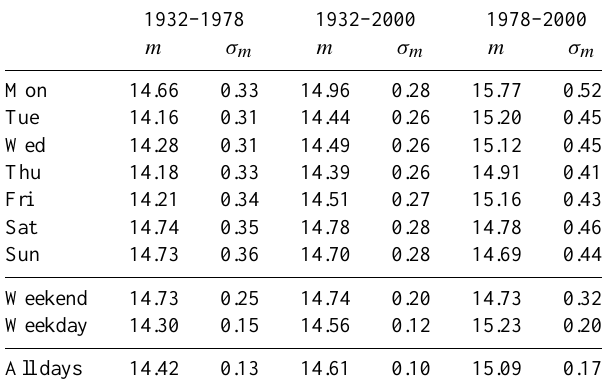
Table 1. Mean values (m) and standard errors ( σ m ) of the A p